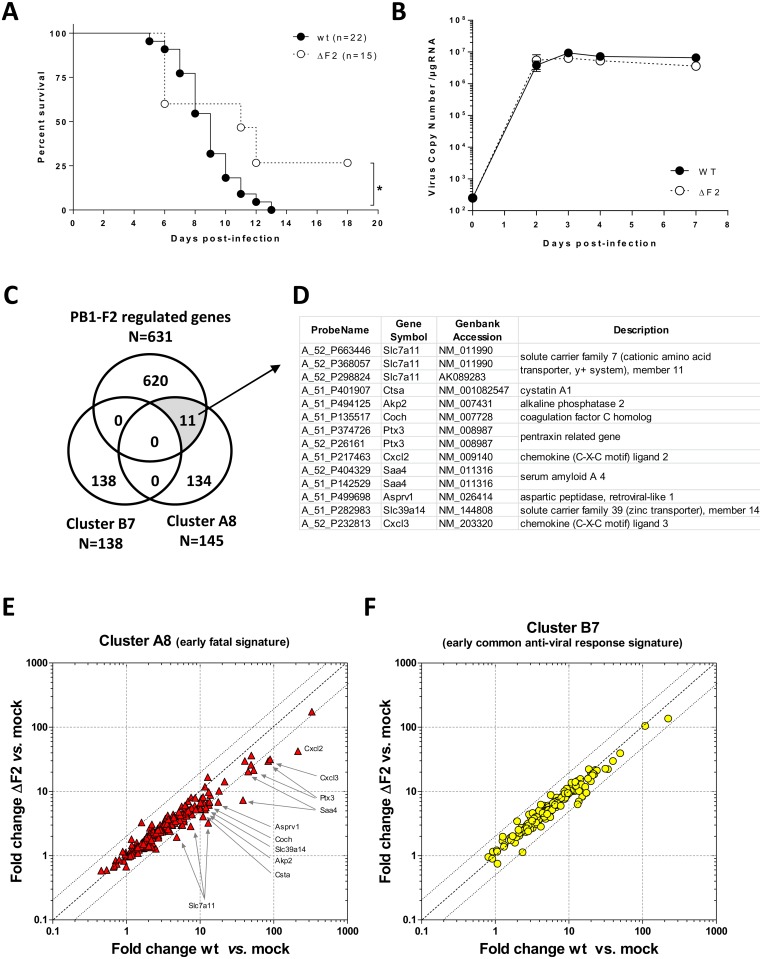
wt and ΔF2 viruses induce different mortality and host responses.(A) Survival curves of C57Bl/6 mice infected with 1x105 PFU of the wt or the ΔF2 IAV. Log-rank (Mantel-Cox) test for comparisons of survival curves indicated a significant difference of the survival curves (* p<0.05). (B) Viral load kinetic in the lungs of IAV-infected mice. Total RNA of lungs from wt-infected (n = 3) and ΔF2-infected (n = 3) C57Bl/6 mice were used to quantify the copies number of IAV segment #7 by qRT-PCR. Results are expressed as RNA copies normalized to the quantity of RNA used in the experiment. (C) Venn diagram showing the distribution of PB1-F2-regulated genes common or unique to cluster A8 and cluster B7. (D) Table depicting the details of PB1-F2-regulated genes belonging to the cluster A8. (E-F) Scatter plots comparing the level of expression of gene cluster A8 (E) and gene cluster B7 (F) in lungs of wt- and ΔF2-infected mice.